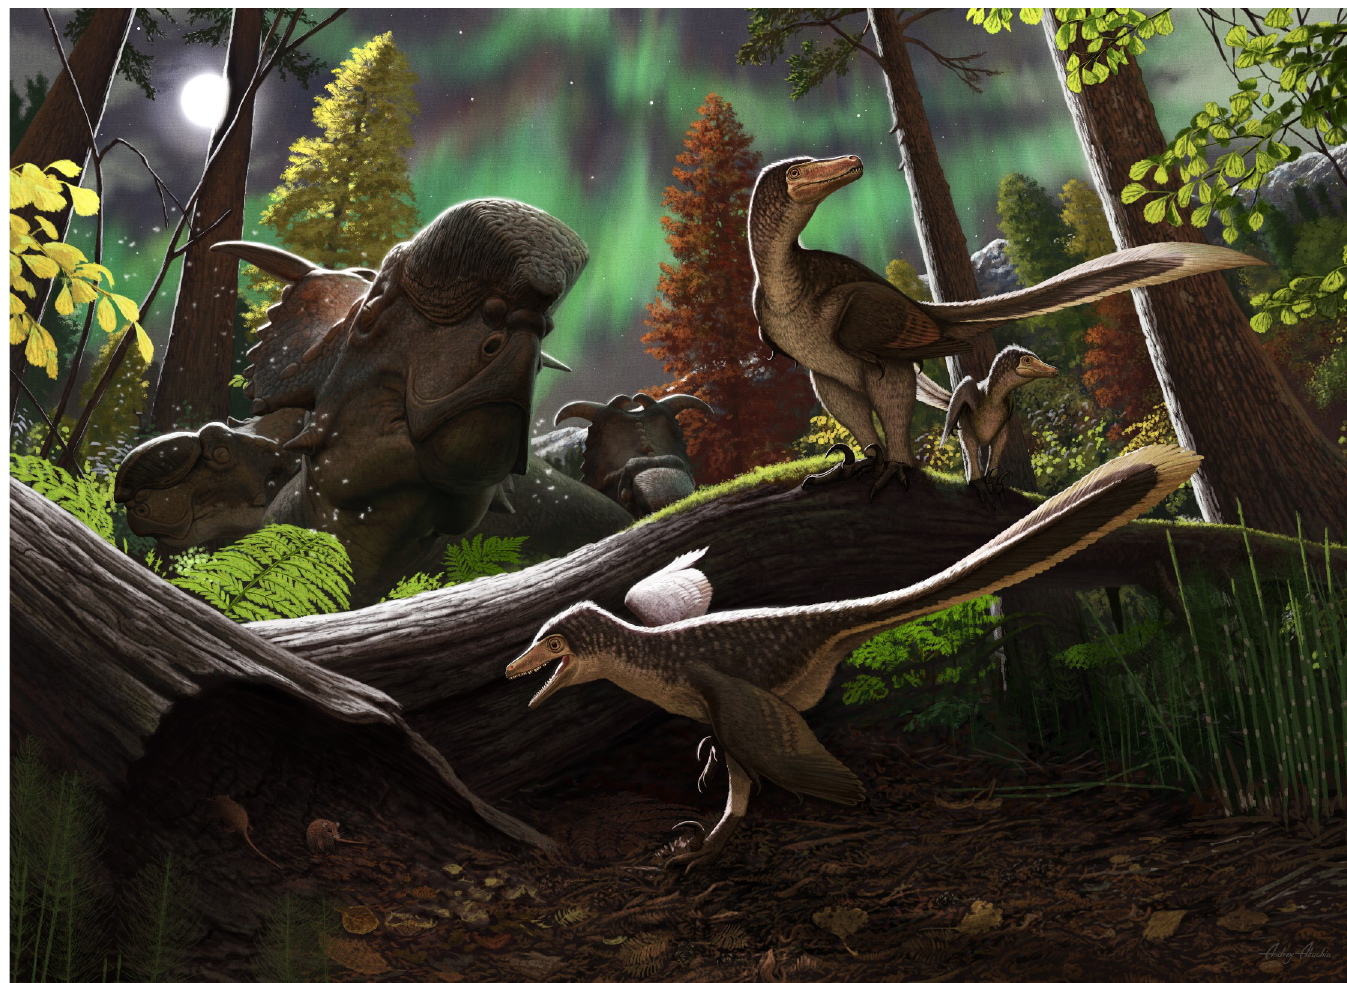
Fig 10. Life reconstruction of the Alaskan saurornitholestine in its environment. Artistic restoration by scientific illustrator Andrey Atuchin depicts a riparian setting in the Prince Creek Formation, matching the geological evidence described in this paper. DMNH 21183 comes from the juvenile dromaeosaurid on the branch close to the adult, while a subadult (foreground) stalks an individual of Unnuakomys hutchisoni [67], a methatherian known from this locality. Individuals of the sympatric ceratopsid Pachyrhinosaurus perotorum [22] rest in the background.